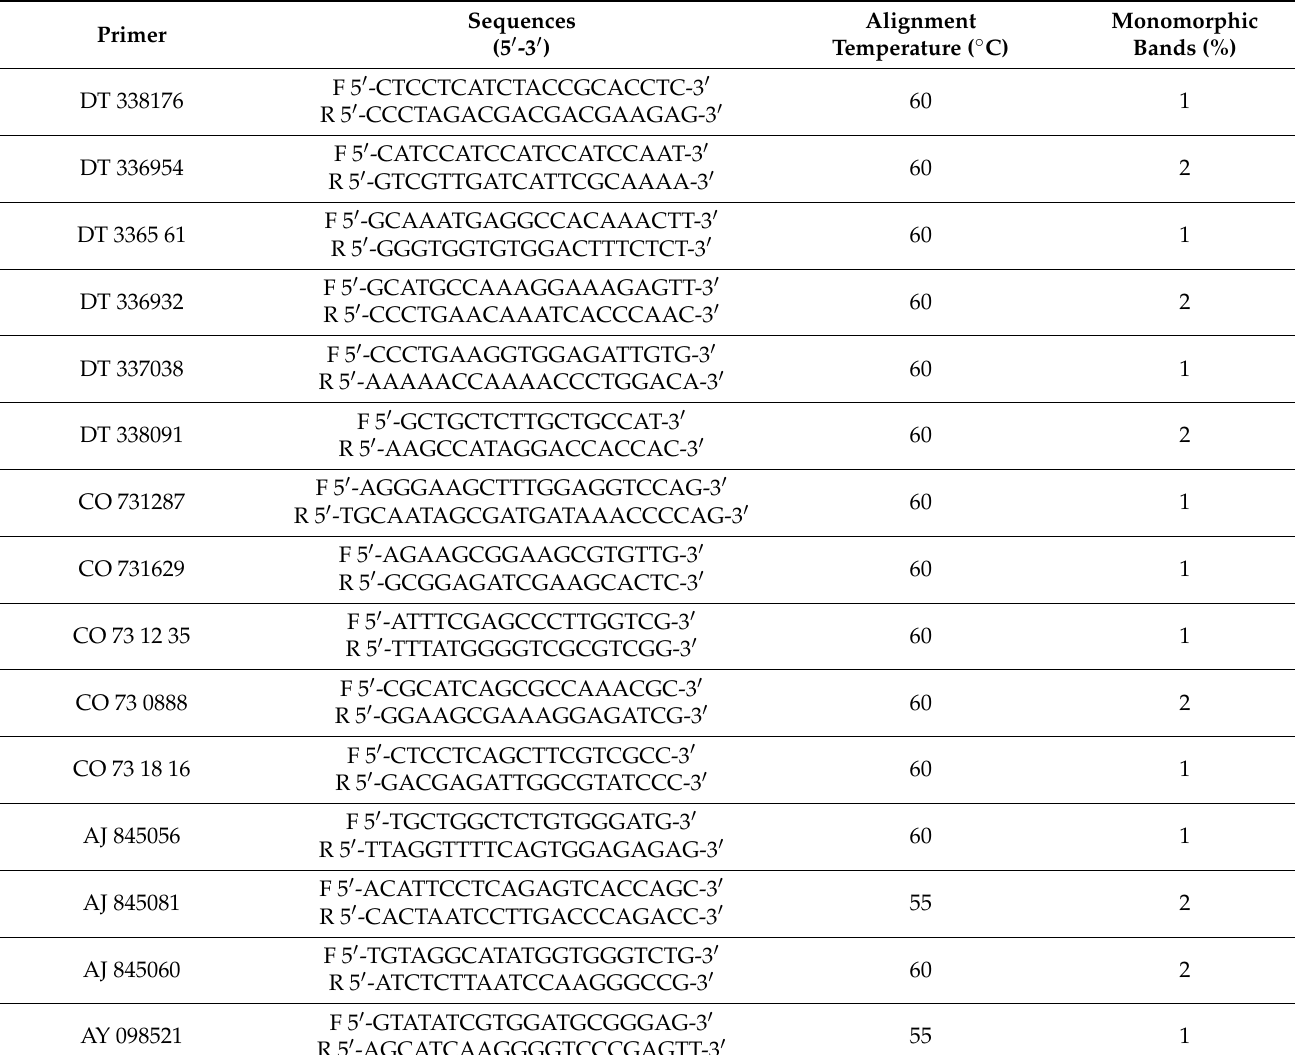
Table 3. SSR primers [19] used in this study, alignment temperature, and the number of monomorphic bands obtained with each